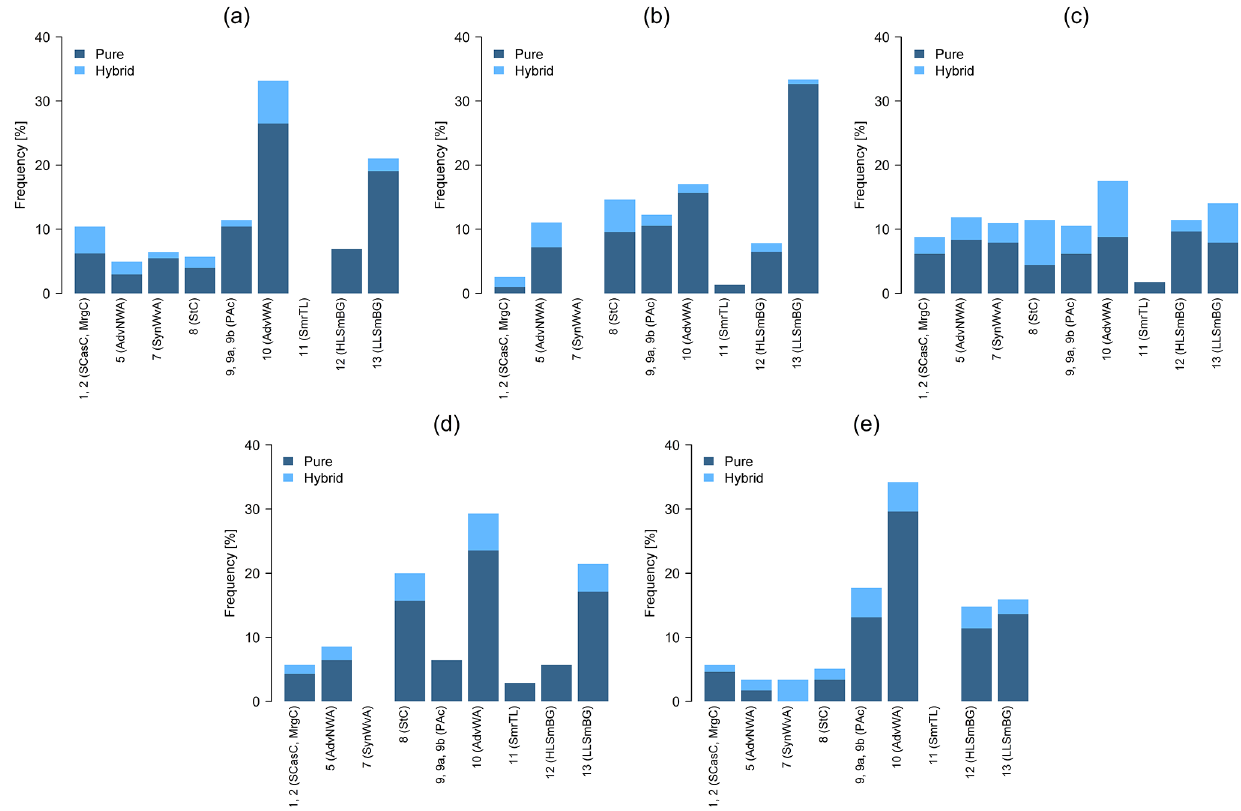
Figure 8. Frequency of mudflows under the synoptic weather types (SWTs) over Uzbekistan during 1984–2013 (March–August): (a) Zeraf- shan basin (101 days); (b) Fergana Valley (147 days); (c) Chirchik–Akhangaran river basin (57 days); (d) Kashkadar’ya basin (35 days); (e) Surkhandar’ya basin (44 days). The definitions of SWT can be seen in Table